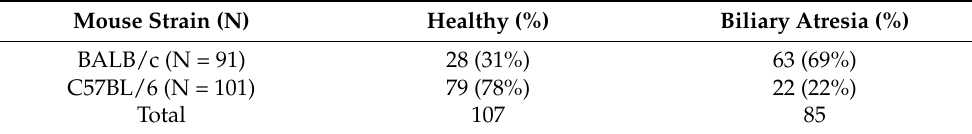
Table 1. Incidence of biliary atresia and recovering pups in RRV-infected BALB/c and C57BL/6 mice. Mouse Strain (N) Healthy (%) Biliary Atresia (%) BALB/c (N =